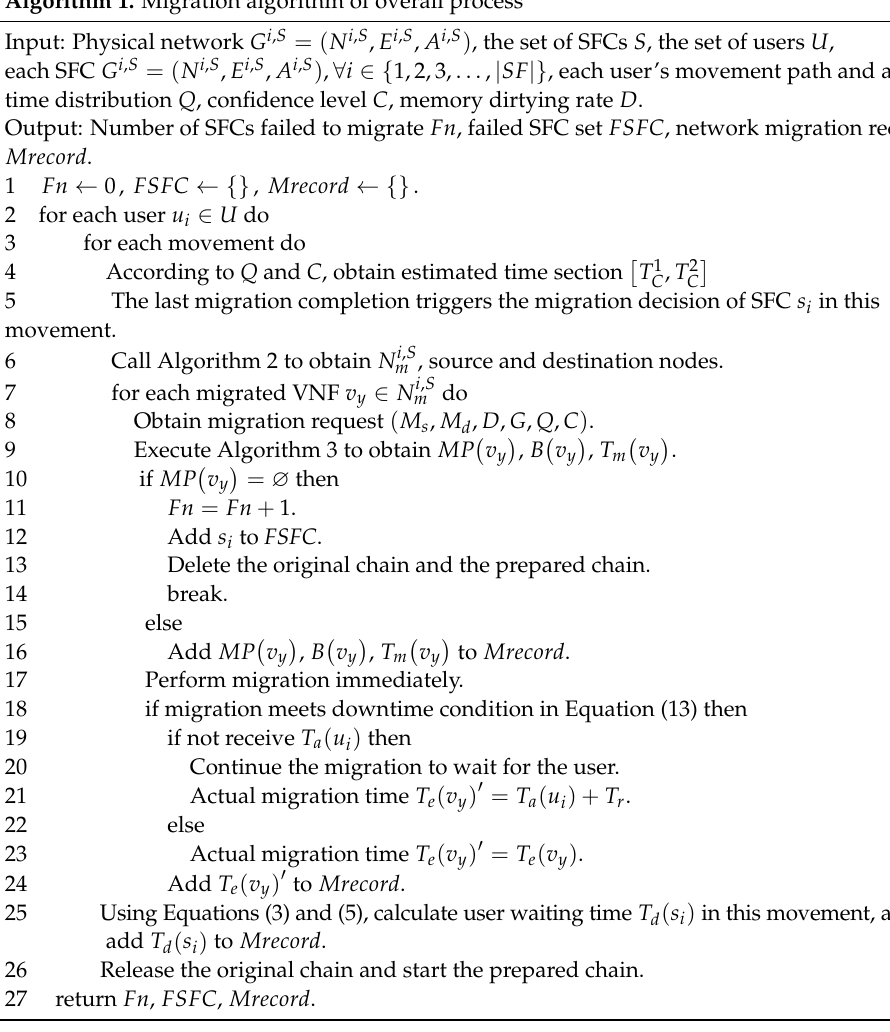
Algorithm 1. Migration algorithm of overall